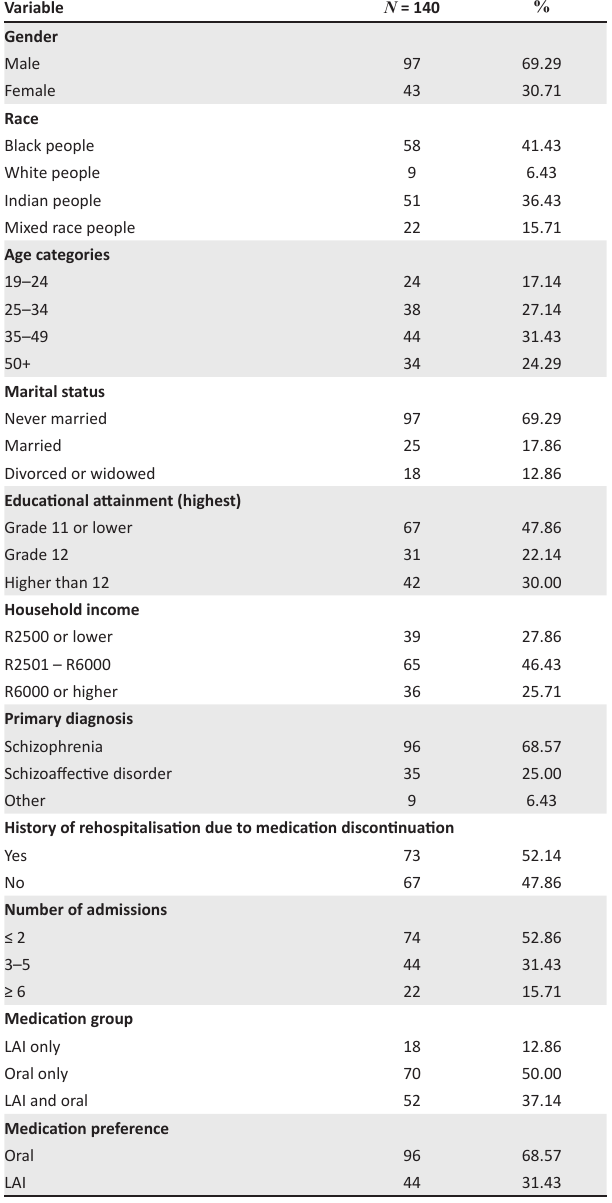
TABLE 1: Sociodemographic and clinical profiles of participants.